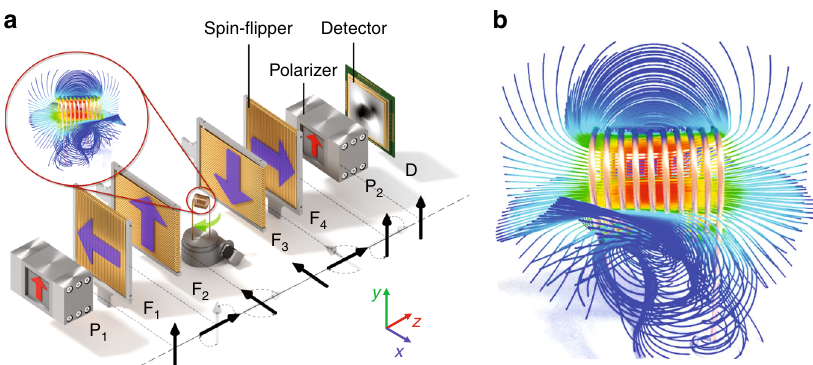
Fig. 1 Tensor tomography. a Schematic drawing of the setup used for tensor tomography with spin-polarized neutrons, comprising spin polarizers (P), spin fl ippers (F) and a detector (D). b Selected magnetic fi eld lines around an electric coil (calculation, see text